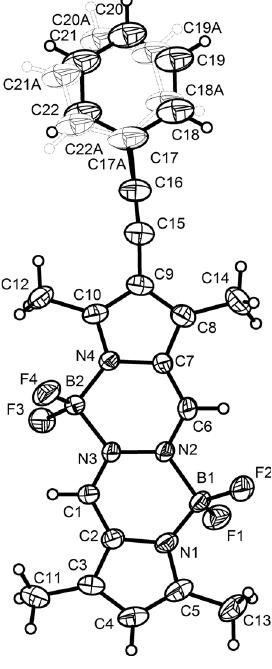
Table  : Data collection and